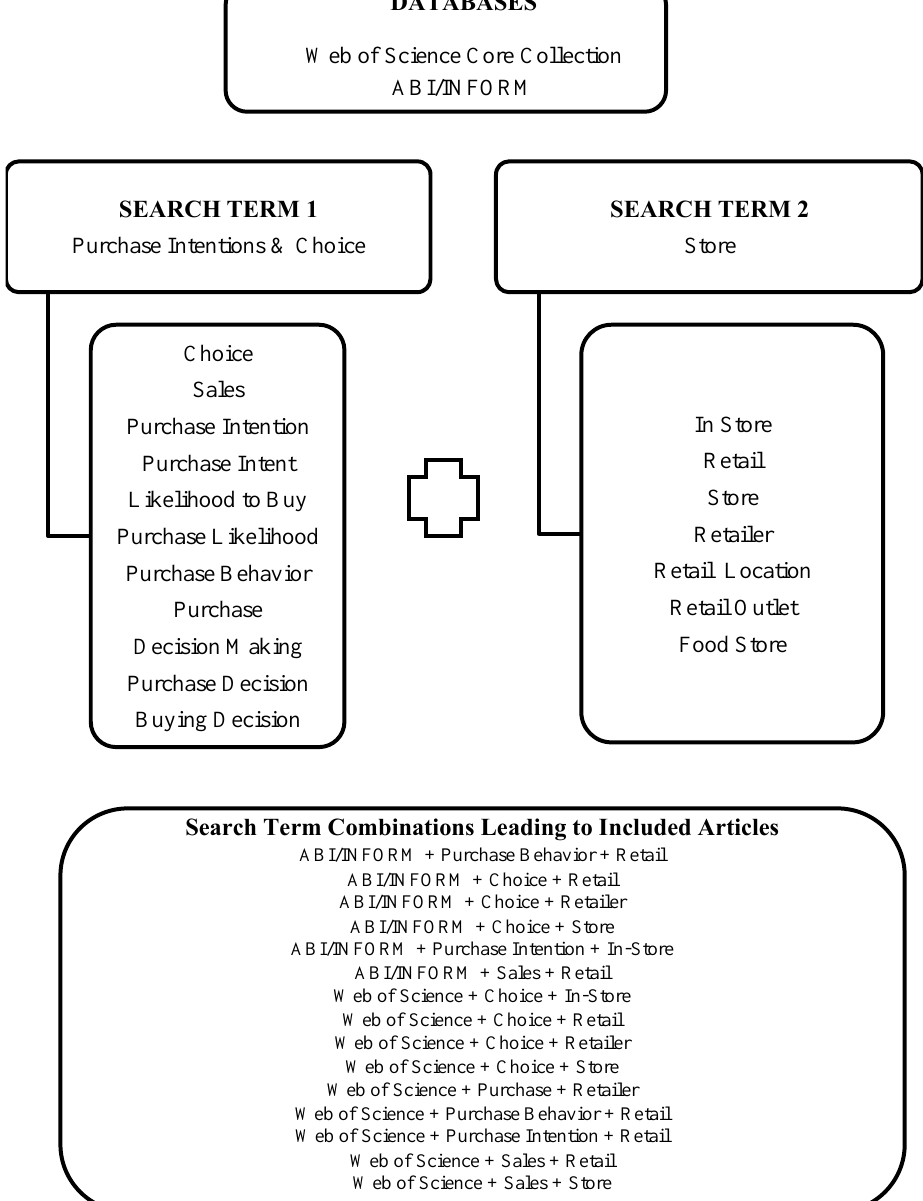
Figure 1. Databases, Search Terms, and Search Combinations Leading to Included Articles